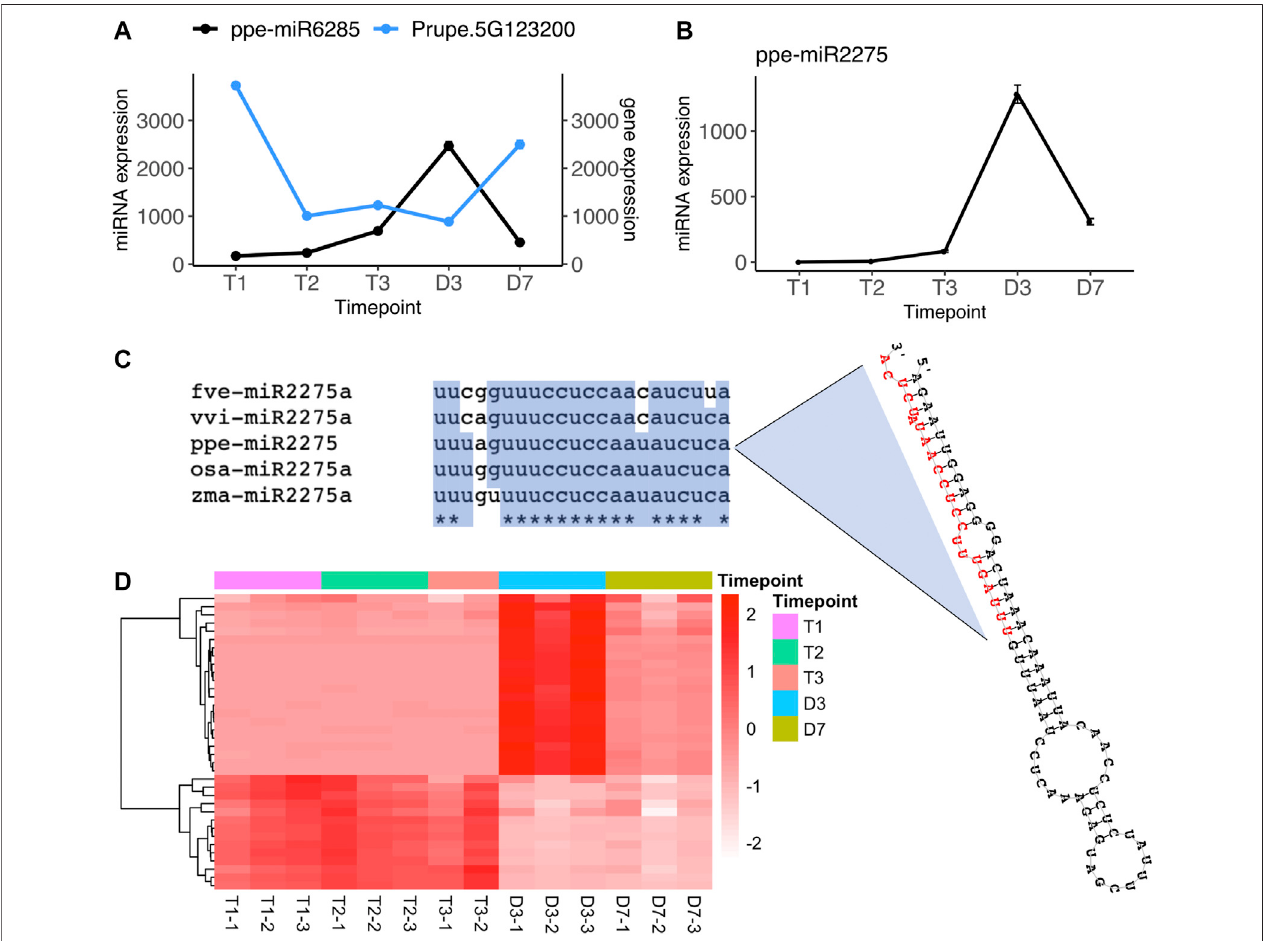
FIGURE 4 | Two microRNAs, ppe-miR6285 and ppe-miR2275 are signi fi cantly upregulated at ecodormancy (A) Gene expression pro fi le of ppe-miR6285 and its target gene Prupe.5G123200 (mean ± SE) (B) Gene expression pro fi le of ppe-miR2275 (mean ± SE) (C) ppe-miR2275 pre-microRNA structure predicted by RNAfold (Lorenz et al., 2011), with mature miR2275 sequence in red, and sequence alignment of mature miR2275 in peach (ppe), rice (osa), maize (zma), strawberry (fve) and grape (vvi) (D) The expression of predicted 24 nt-phasiRNA loci targeted by ppe-miR2275 with each row indicating a 24 nt-siRNA locus and with each column representing one sample. The color scale indicates relative expression levels of the 24 nt-siRNAs over the fi ve time points.